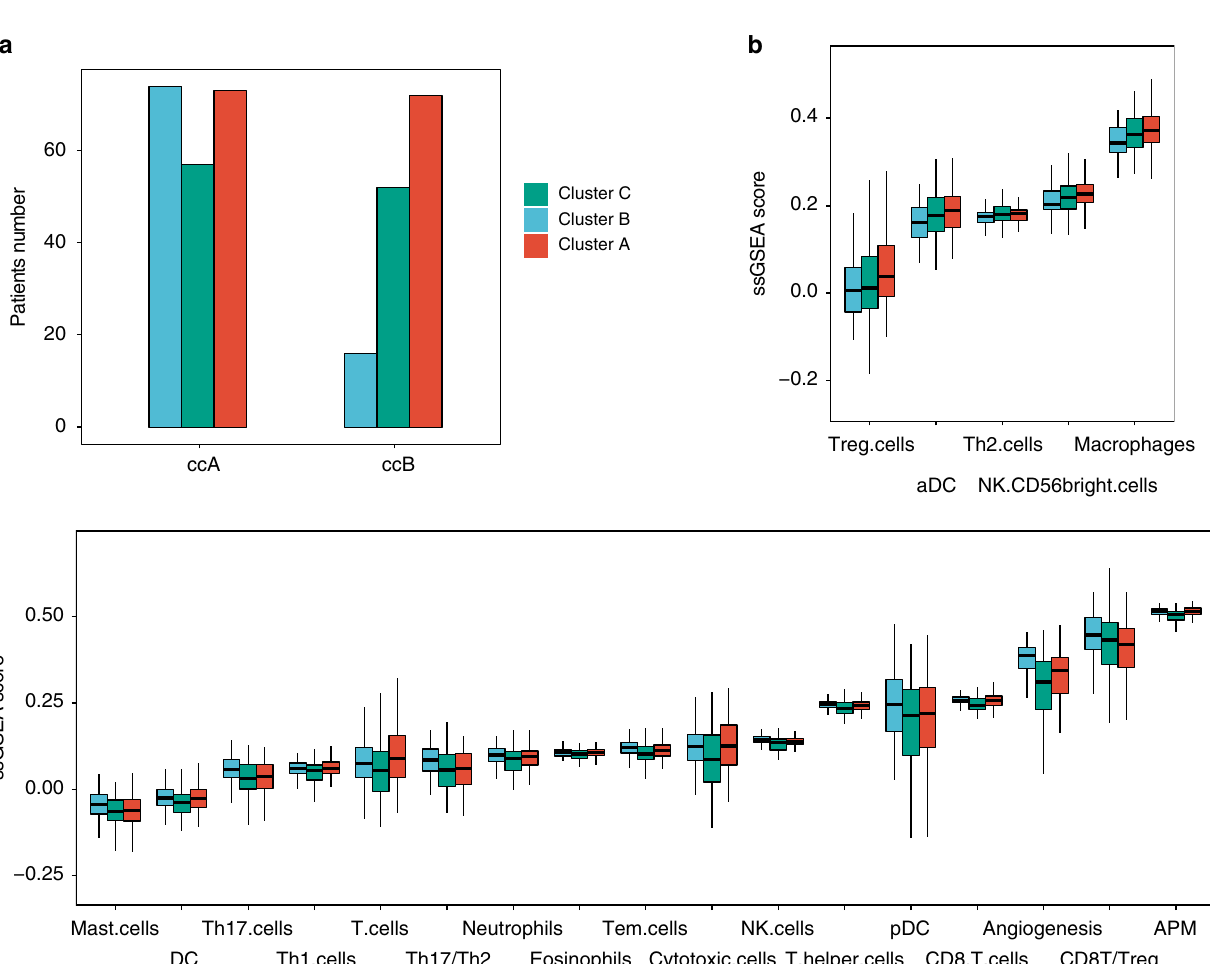
Fig. 5 Expression and immune features of different subgroups of ccRCC. a The numbers of ccA and ccB tumors in each cluster are shown. b Signature genes downregulated in cluster B relative to clusters A and C. c Signature genes upregulated in cluster B relative to clusters A and